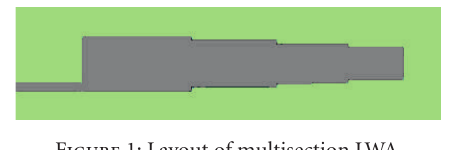
Figure 1: Layout of multisection LWA.